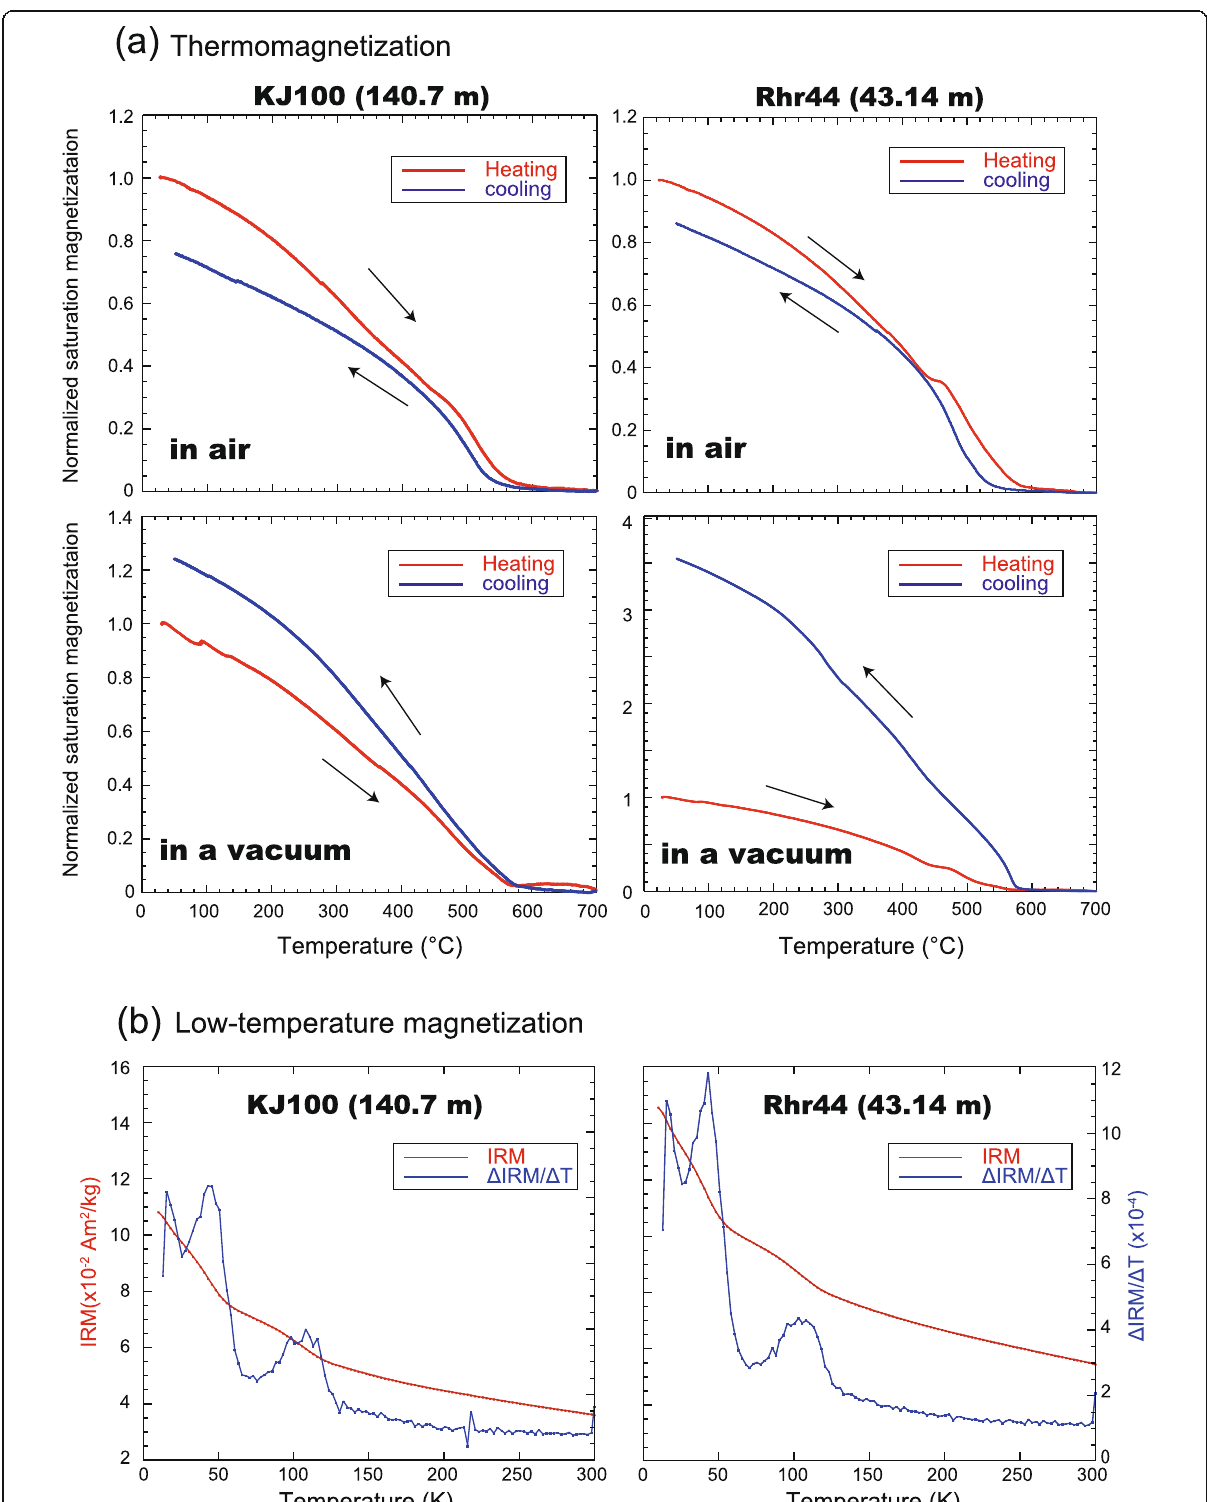
Fig. 3 Typical results of thermomagnetic and low-temperature magnetic experiments. a Results of thermomagnetic experiments. Left (right) diagrams indicate results from specimen KJ100 (Rhr44). Upper (lower) diagrams indicate results in air (a vacuum). b Results of low-temperature experiments. The left (right) diagram indicates results from specimen KJ100